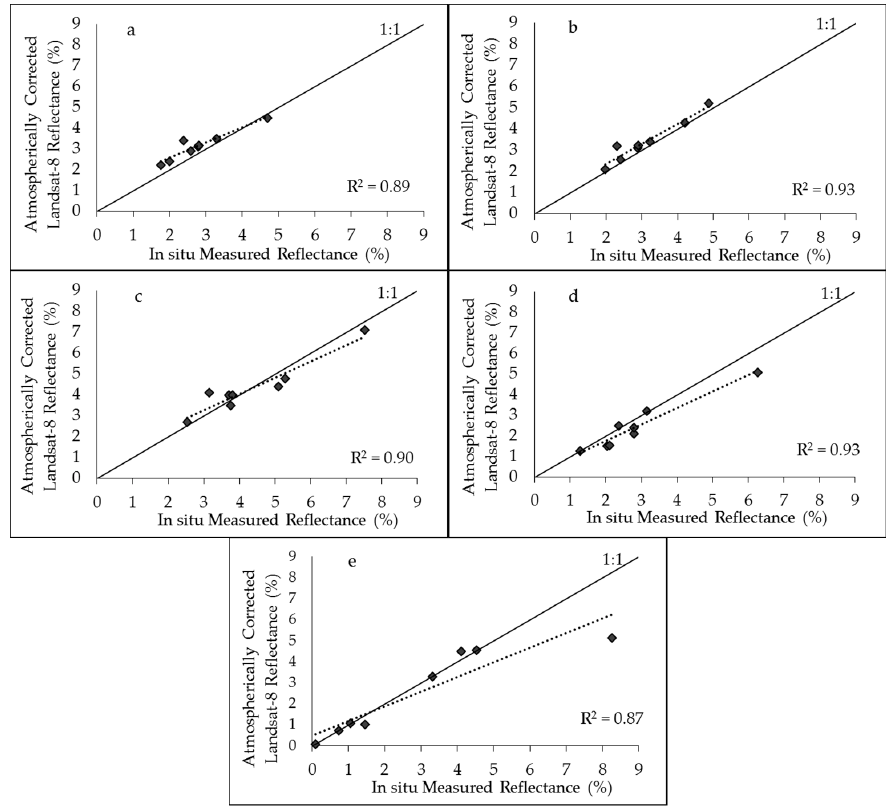
Figure 3. Comparison of atmospherically corrected Landsat-8 band reflectance (September 2016 image) and in situ measured reflectance (i.e., by FieldSpec Spectroradiometer) of eight locations surveyed in September 2016. Given bands are: ( a ) band 1, ( b ) band 2, ( c ) band 3, ( d ) band 4, and ( e ) band 5.